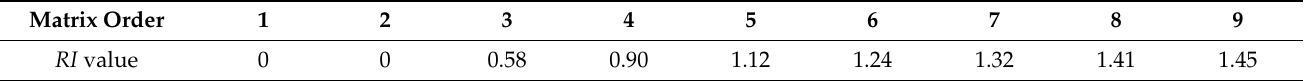
Table 3. The RI is the average random consistency